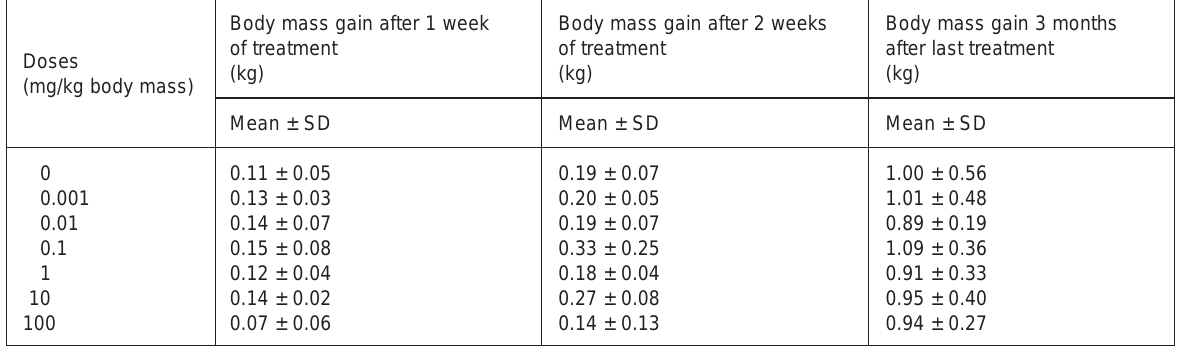
FIG. 1 Cytotoxicity in primary CES cells of an aqueous decoc- FIG. 2 Inhibition of fowlpox virus CPE by a decoction from galls tion from galls of Guiera senegalensis of Guiera TABLE 1 Body mass of chickens taken after 7 and 14 days of continuous treatment with various concentrations of decoctions from galls of Guiera senegalensis, as well as after a 3-month observation period